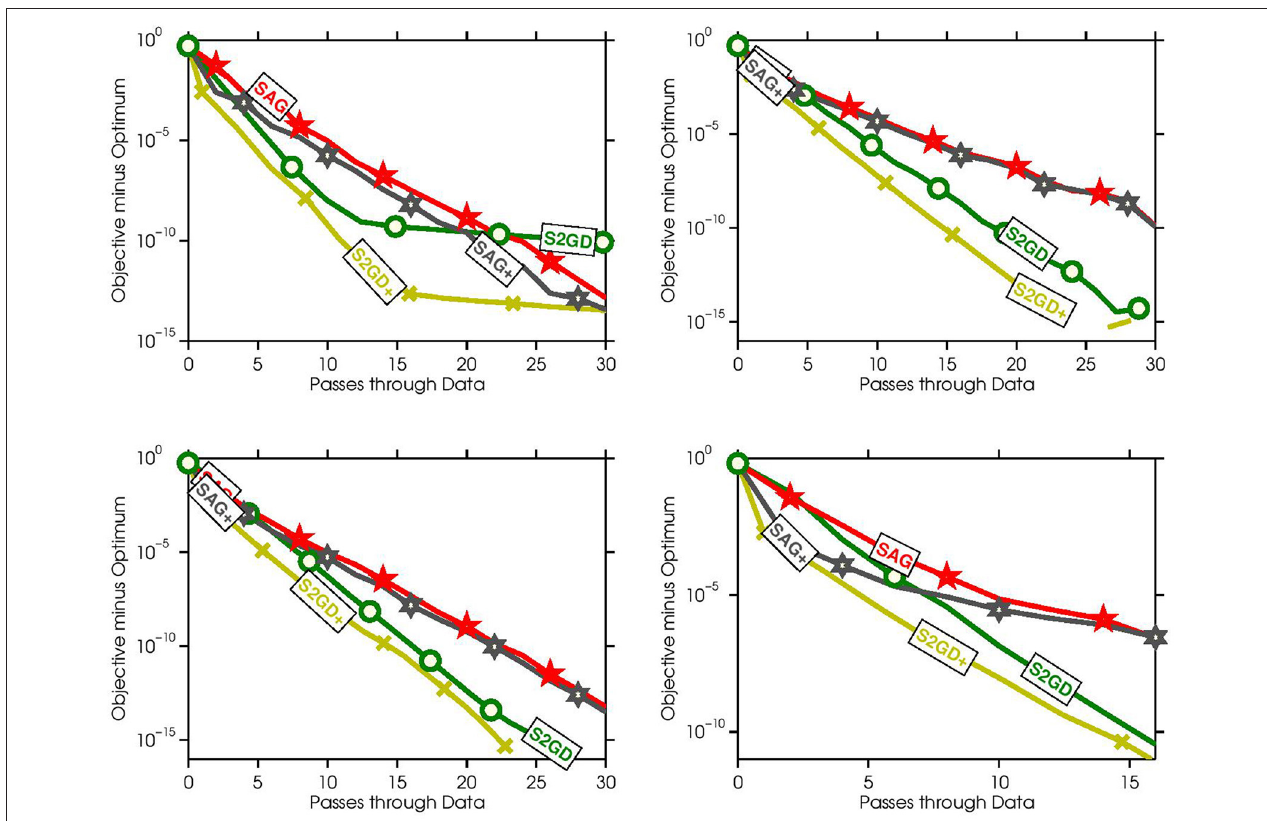
FIGURE 3 | Practical performance of boosted methods on datasets ijcnn, rcv (first row), realsim, url (second